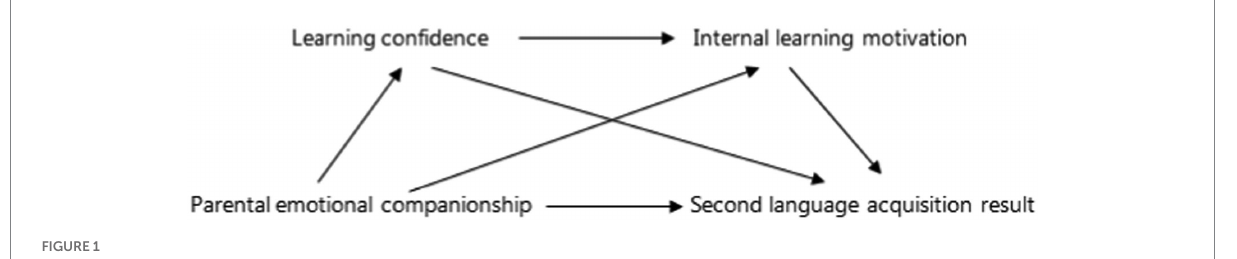
FIGURE 1 Theoretical model